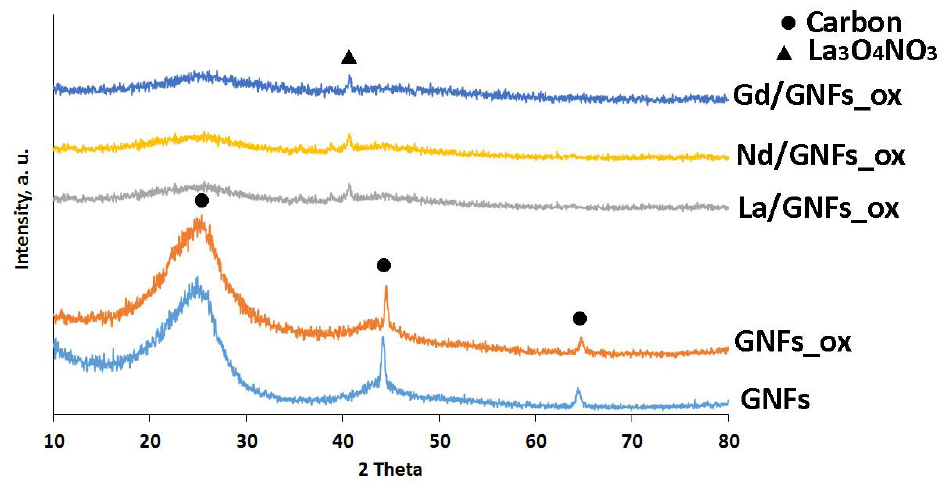
Figure 5. X-ray data of GNFs, GNFs_ox, and Ln/CNFs_ox.